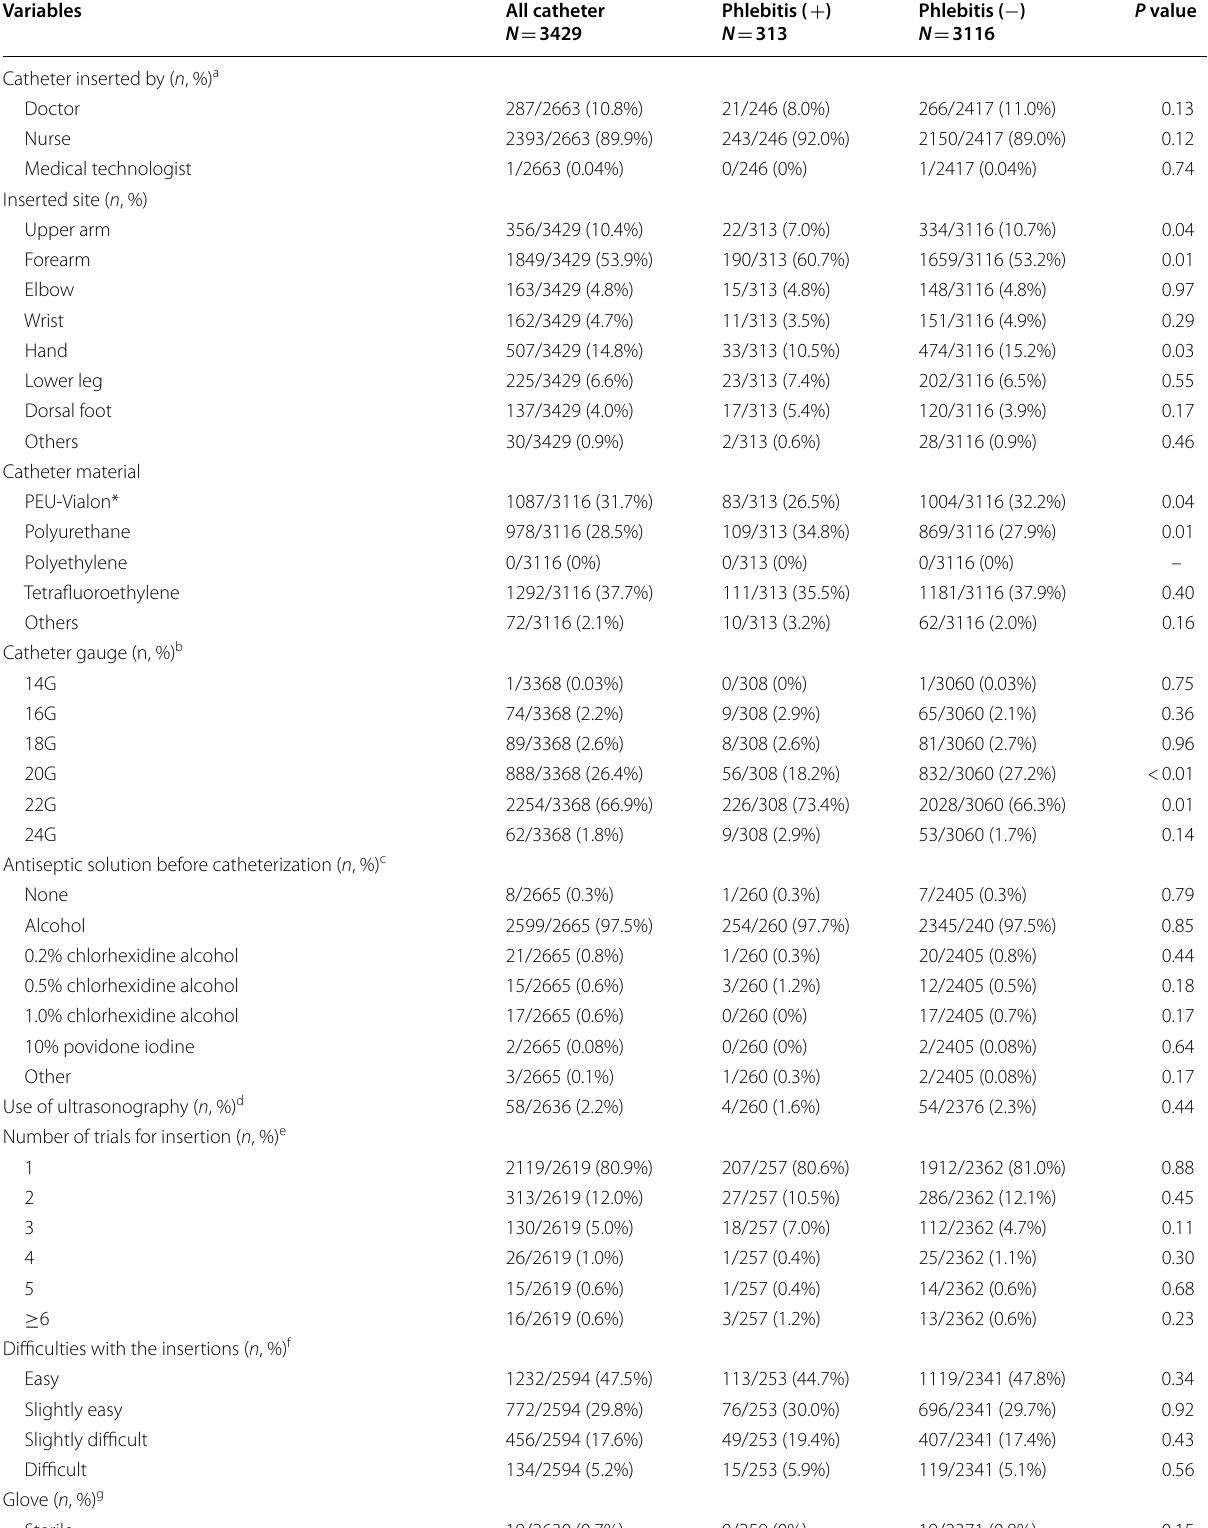
Table 2 All PIVC characteristics during insertion with or without